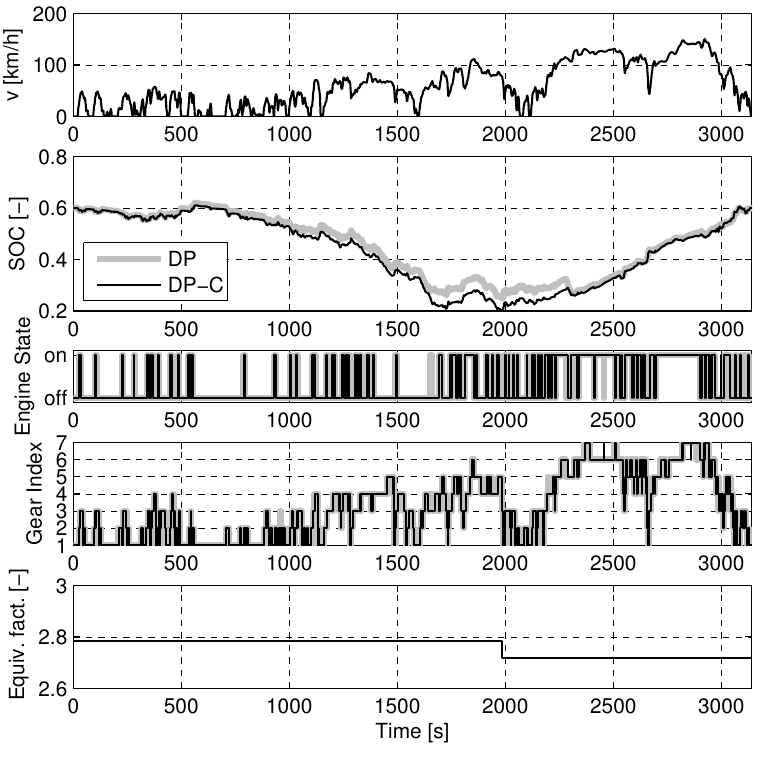
Figure 9. Comparison of the results obtained with DP and the DP-C algorithm on the Common Artemis Driving Cycle (CADC) driving cycle.